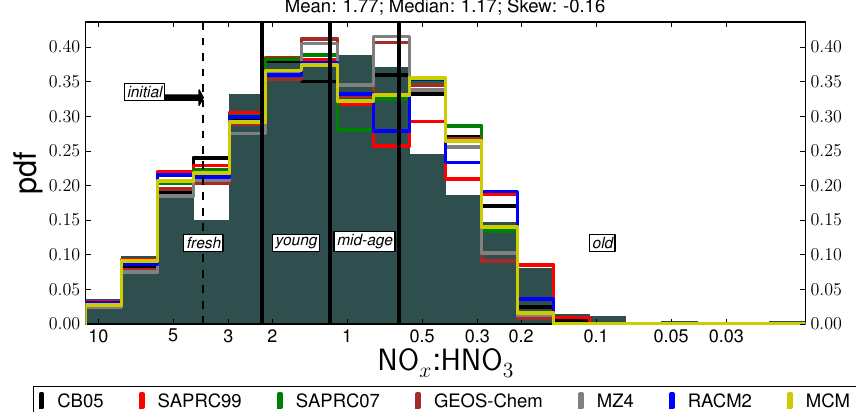
Fig. 4. Observed NO x :HNO 3 (bars) compared to simulated (lines) from each chemical mechanism using the optimized, bias-corrected statistical model.